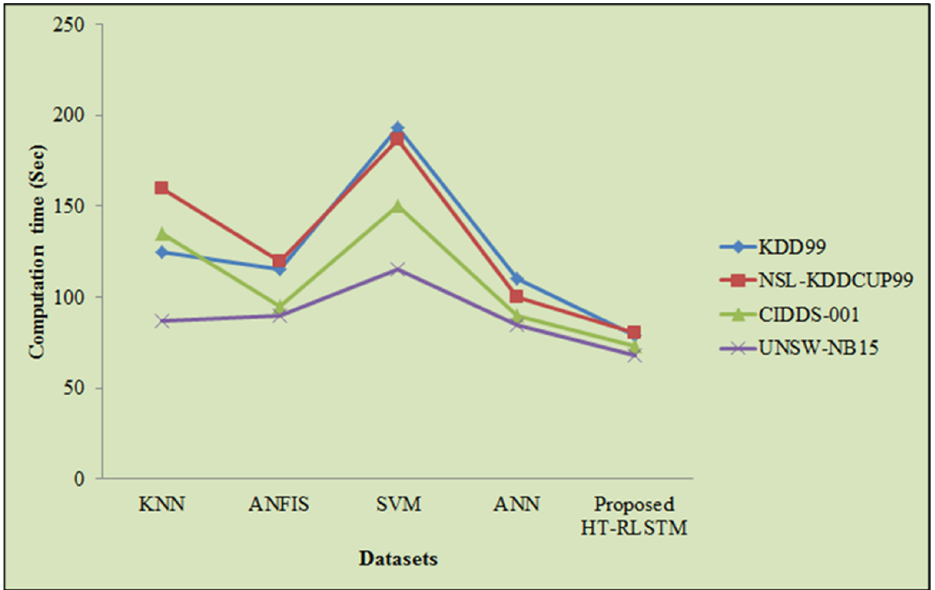
Figure 6. Comparative analysis of the proposed HT-RLSTM based on computation time.